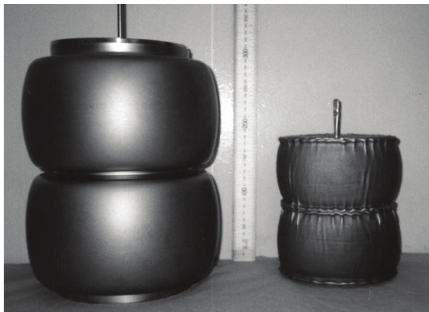
Figure 3: One of the many types of HIP can dumbbell designs showing how the can collapses to a near cylindrical shape (left before, right after HIPing). This 13.5kg can contains Synroc-C. The HIPed can is 19cm high by 15.5 cm in